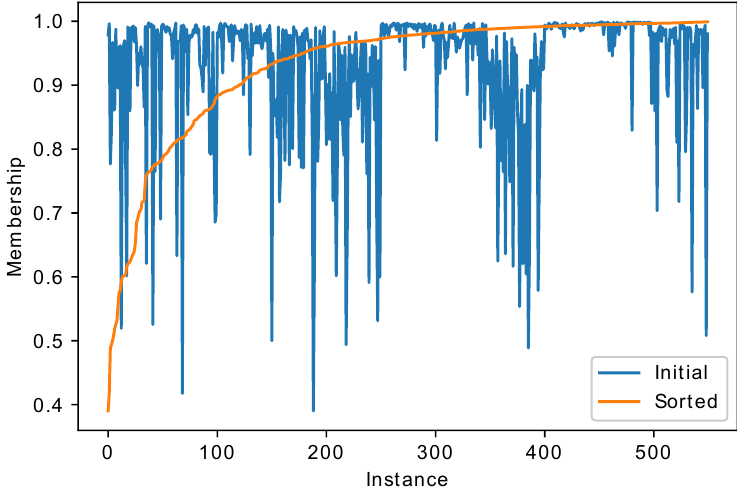
Figure 4. Neural net outputs returned from softmax layer for the true class, texture dataset, test